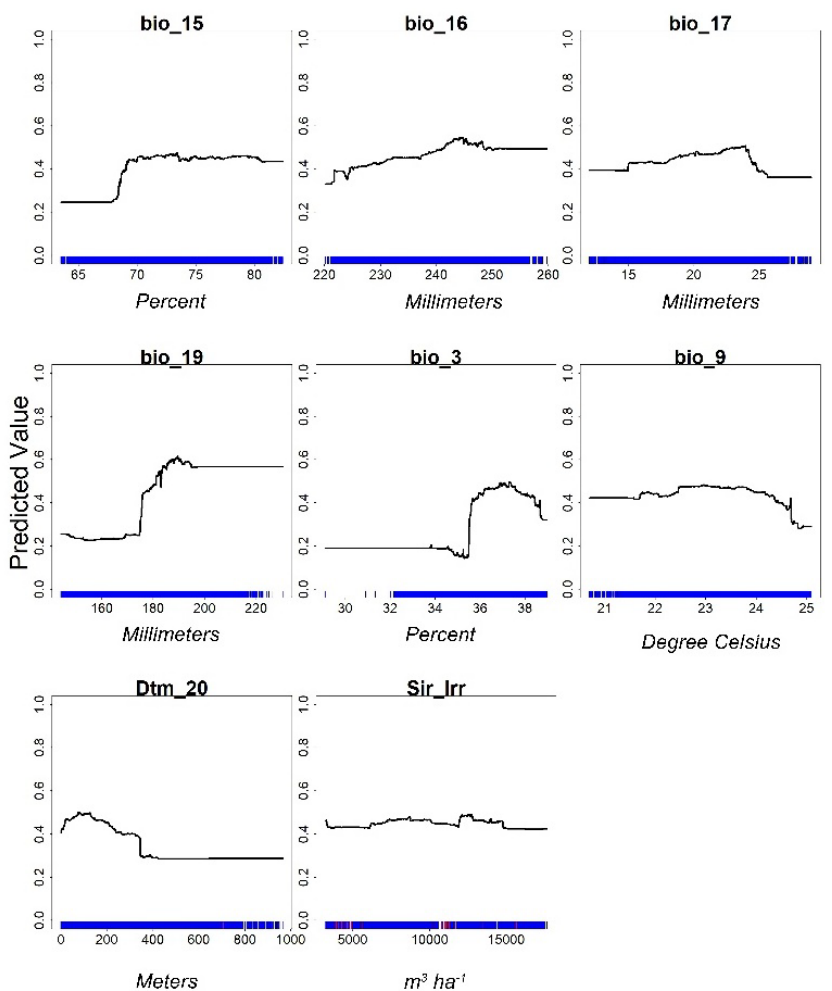
Figure 7. ResponseCurves of the predictors for the RF model, for the case study analysed. The predictors Bio_15 (Precipitation Seasonality (Coefficient of Variation)), Bio_16 (Precipitation of Wettest Quarter), Bio_19 (Precipitation of Coldest Quarter), Bio_9 (Mean